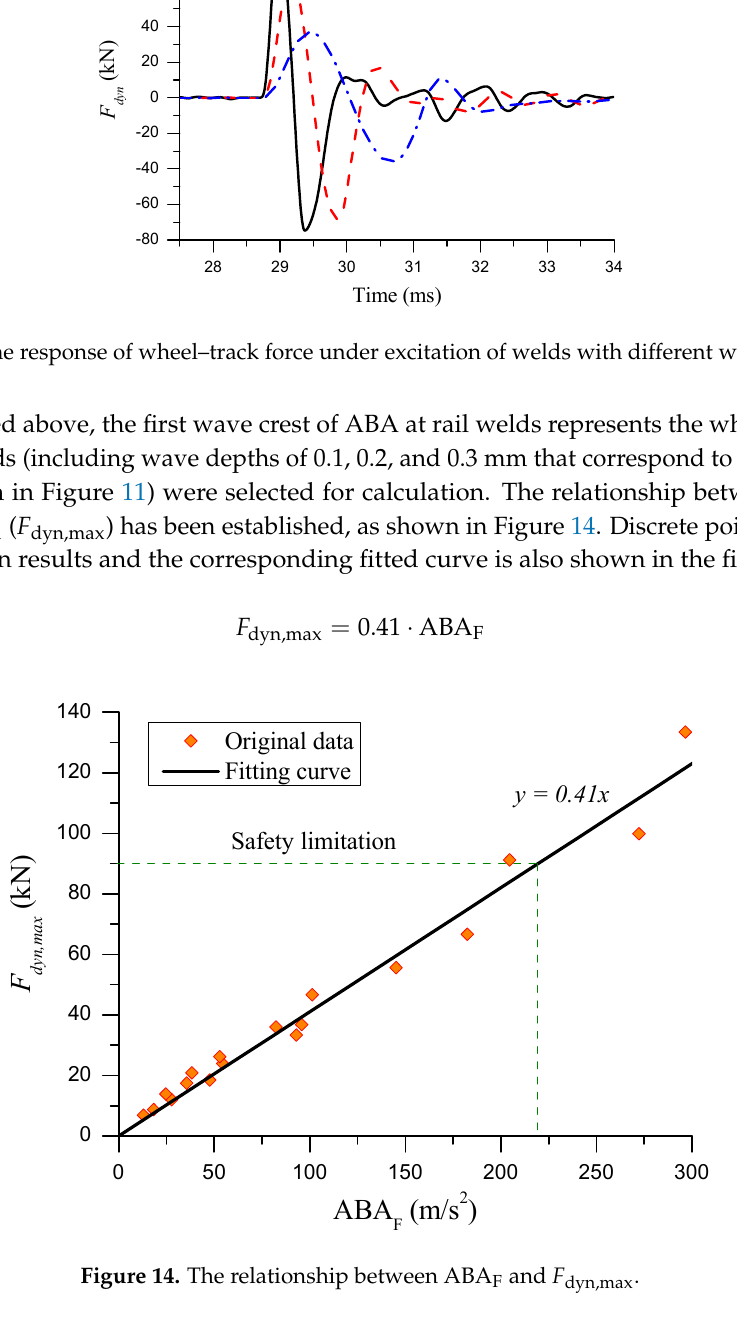
F and F dyn,max